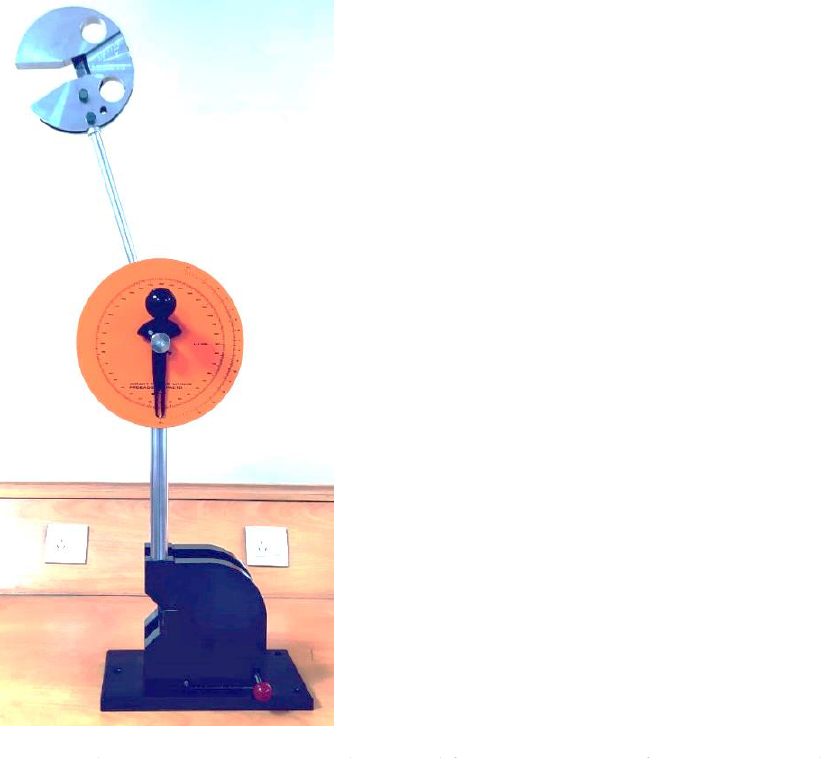
Figure 5. Charpy impact testing machine used for impact testing of composite samples.